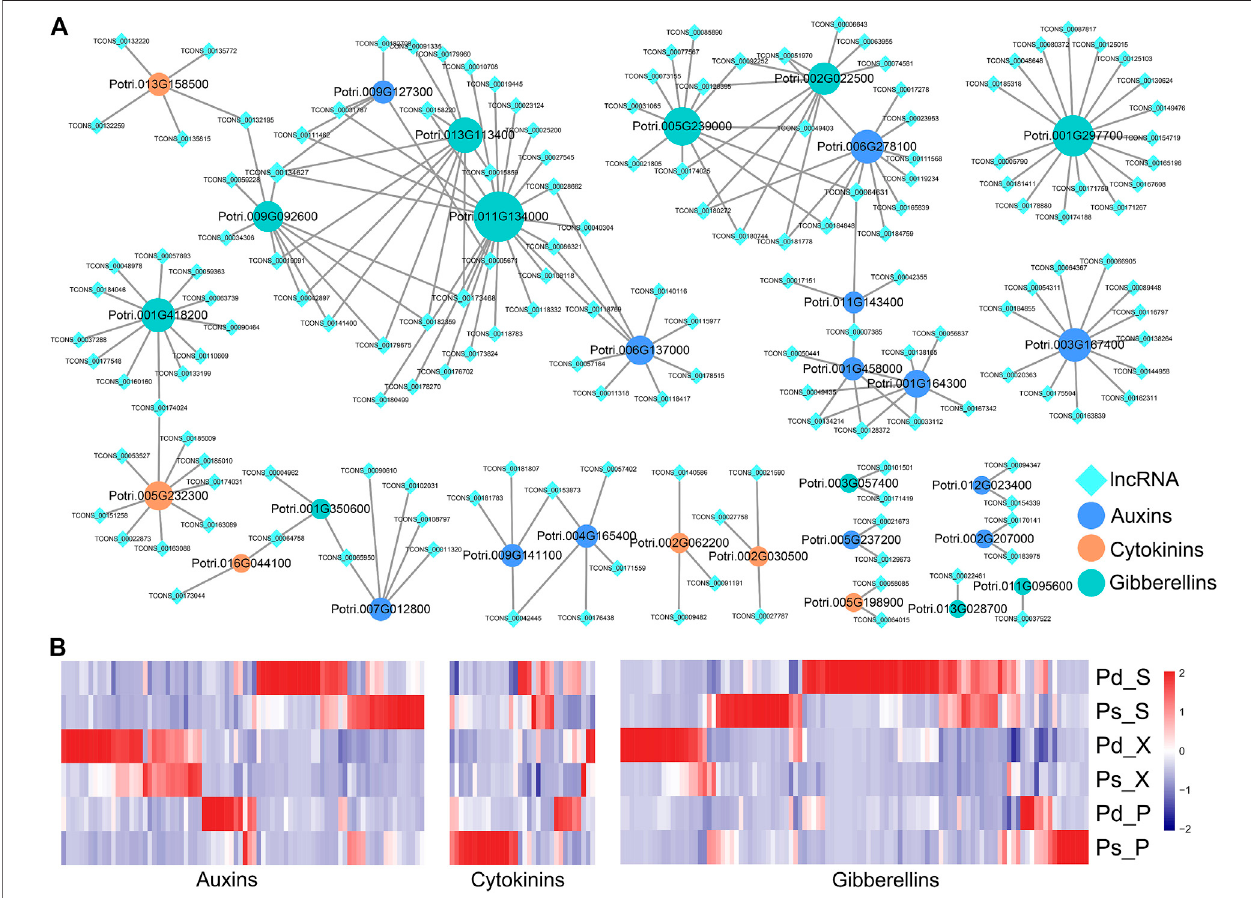
FIGURE 6 | lncRNAs related to plant hormone biosynthesis and signal transduction. (A) Co-expression network of DElncRNAs and protein coding genes (PCgenes)involvedinauxin,cytokinin,andgibberellinbiosynthesisandsignaltransduction. (B) ExpressionofselectedlncRNAsandtheirpredictedco-expressiontarget PCgenes involved in plant hormone biosynthesis signal transduction.